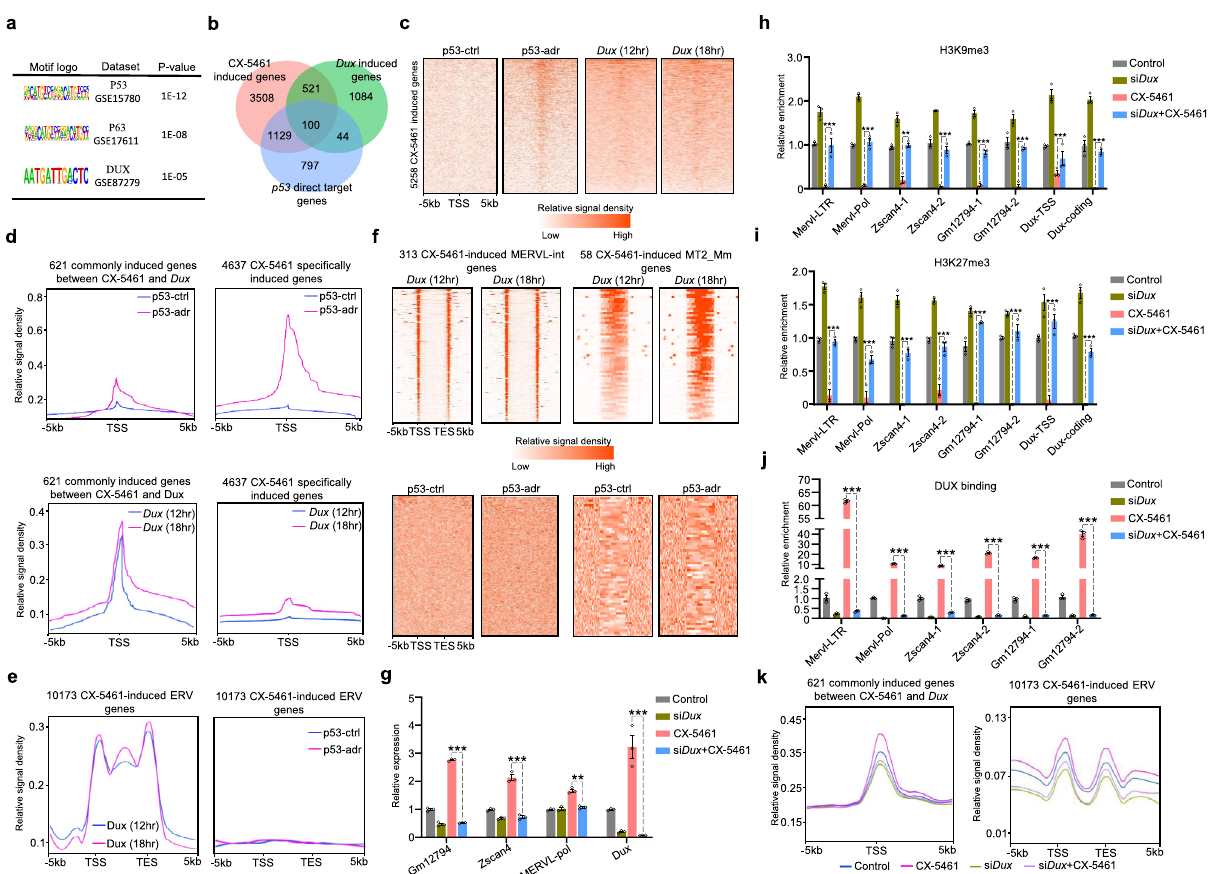
Fig. 5 2C/ERV genes were activated through the Dux . a Enriched binding motifs of 5258 genes induced by CX-5461 treatment. b Venn diagrams showing the overlap among CX-5461 treatment induced genes, p53 activated direct target genes and Dux -overexpression induced genes. c Heatmap plots demonstrate the binding of p53 and Dux proteins on within 5 kb region around transcription start sites of 5258 CX-5461 induced genes using published P53 ChIP-seq data and DUX ChIP-seq data. GEO accession code GSE26360 for P53 and GEO accession code GSE85632 for DUX . d Line plots demonstrate the meta-analysis results of P53 and DUX on within 5 kb region around transcription start sites of 621 commonly induced genes between CX-5461 treatment and Dux overexpression and 4637 speci fi cally induced genes by CX-5461 using published P53 ChIP-seq data and DUX ChIP-seq data. GEO accession code GSE26360 for P53 and GEO accession code GSE85632 for DUX. e Line plots demonstrate the meta-analysis results of P53 and DUX protein on within 5kb region around transcription start and end sites of 10,173 CX-5461 induced ERV genes using published P53 ChIP-seq data and DUX ChIP-seq data. The regions of different lengths of gene body were fi tted to 5 kb. GEO accession code GSE26360 for P53 and GEO accession code GSE85632 for DUX. f Heatmap plots demonstrate the binding of P53 and DUX proteins on within 5 kb region around transcription start and end sites of 5258 CX-5461 induced MERVL-int and MT2_Mm genes; The regions of different lengths of gene body were fi tted to 5 kb. GEO accession code GSE26360 for P53 and GEO accession code GSE85632 for DUX. g qRT-PCR showing the expression of Dux or 2C-related genes in Dux silenced mES cells; GM12794 : p = 1.21E − 13(***), Zscan4 : p = 3.00E − 09(***), MERVL-pol: p = 4.55E − 03(**), Dux : p = 9.60E − 14(***), two-way ANOVA; N = 3 biologically independent ChIP-qPCR experiment; Data are presented as mean values + / − SEM. SEM standard error of mean. h ChIP-PCR showing H3K9me3 levels of Dux or 2C-related genes in Dux silenced mES cells; MERVL-LTR: p = 1.04E − 11(***), MERVL-Pol: p = 9.68E − 12(***), Zscan4-1: p = 2.51E − 10(**), Zscan4-2: p = 1.67E − 11(***), Gm12794-1: p = 1.90E − 09(***), Gm12794-2: p = 2.66E − 11(***), Dux-TSS: p = 1.35E − 04(*), Dux-coding: p = 4.92E − 11(***), two-way ANOVA; N = 3 biologically independent ChIP-qPCR experiment; Data are presented as mean values + / − SEM. SEM standard error of mean. i ChIP-PCR showing H3K27me3 levels of Dux or 2C-related genes in Dux silenced mES cells; MERVL-LTR: p = 9.87E − 12(***), MERVL-Pol: p = 2.05E − 08(***), Zscan4-1: p = 1.12E − 11(***), Zscan4-2: p = 5.81E − 10(**), Gm12794-1: p = 9.56E − 12(***), Gm12794-2: p = 9.55E − 12(***), Dux-TSS: p = 9.55E − 12(***), Dux-coding: p = 1.02E − 11(***), two-way ANOVA; N = 3 biologically independent ChIP-qPCR experiment; Data are presented as mean values + / − SEM. SEM standard error of mean. j ChIP-PCR showing DUX protein binding levels on 2C-related genes in Dux silenced mES cells; MERVL-LTR: p < 1.00E − 15(***), MERVL-Pol: p < 1.00E − 15 (***), Zscan4-1: p < 1.00E − 15(***), Zscan4-2: p < 1.00E − 15(***), Gm12794-1: p < 1.00E − 15(***), Gm12794-2: p < 1.00E − 15(***), two-way ANOVA; N = 3 biologically independent ChIP-qPCR experiment; Data are presented as mean values + / − SEM. SEM standard error of mean. k Line plots demonstrate the meta-analysis results of chromatin accessibility in Dux silenced mES cells within 5 kb region around transcription start sites or transcription start and end sites of 621 commonly induced genes between CX-5461 treatment and Dux overexpression and 10,173 CX-5461 induced ERV genes. The regions of different lengths of ERV genes were fi tted to 5 kb. GEO accession code GSE166041. p53-ctrl: untreated mES cells, p53-adr: mES cells treated with adriamycin, a DNA damage agent widely used to activate p53 , Dux (12 h): mES induced with doxycycline for 12 h, Dux (18 h): mES induced with doxycycline for 18 h. Source data are provided as a Source Data fi